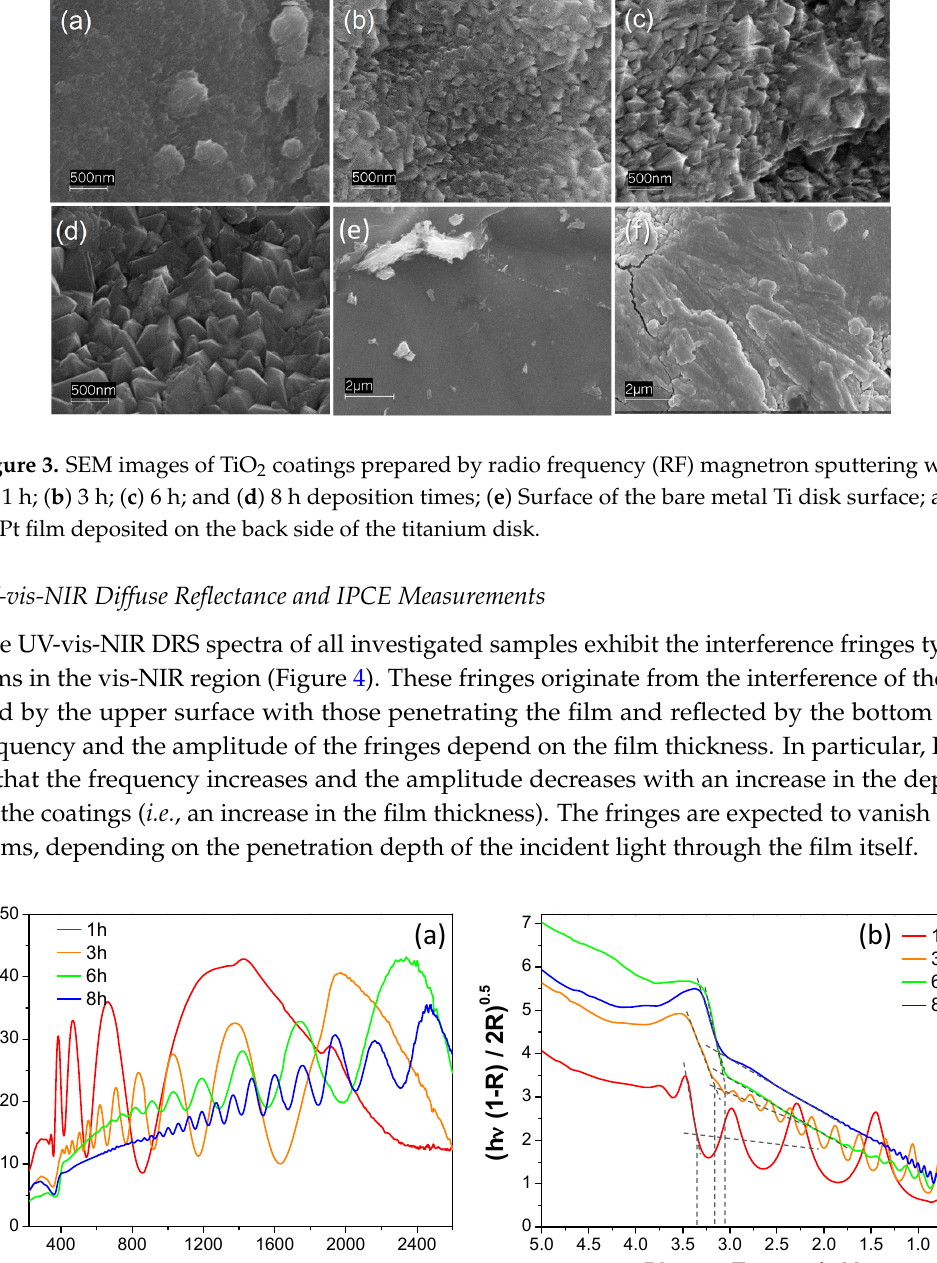
Figure 4. UV-vis-NIR diffuse reflectance spectra of the TiO 2 coatings on a metal Ti disk for different deposition time. ( a ) Percent reflectance vs. wavelength spectra; and ( b ) corresponding Kubelka-Munk transform used for band gap calculation.